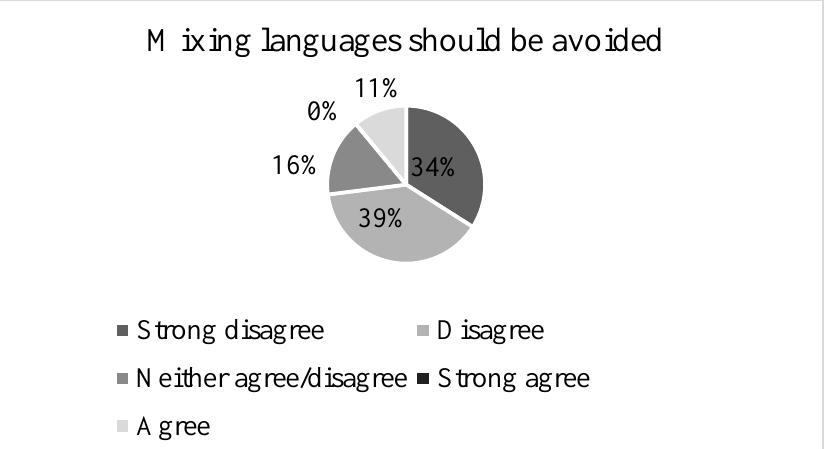
Figure 5. Participants’ attitudes toward mixing languages (Should be avoided)